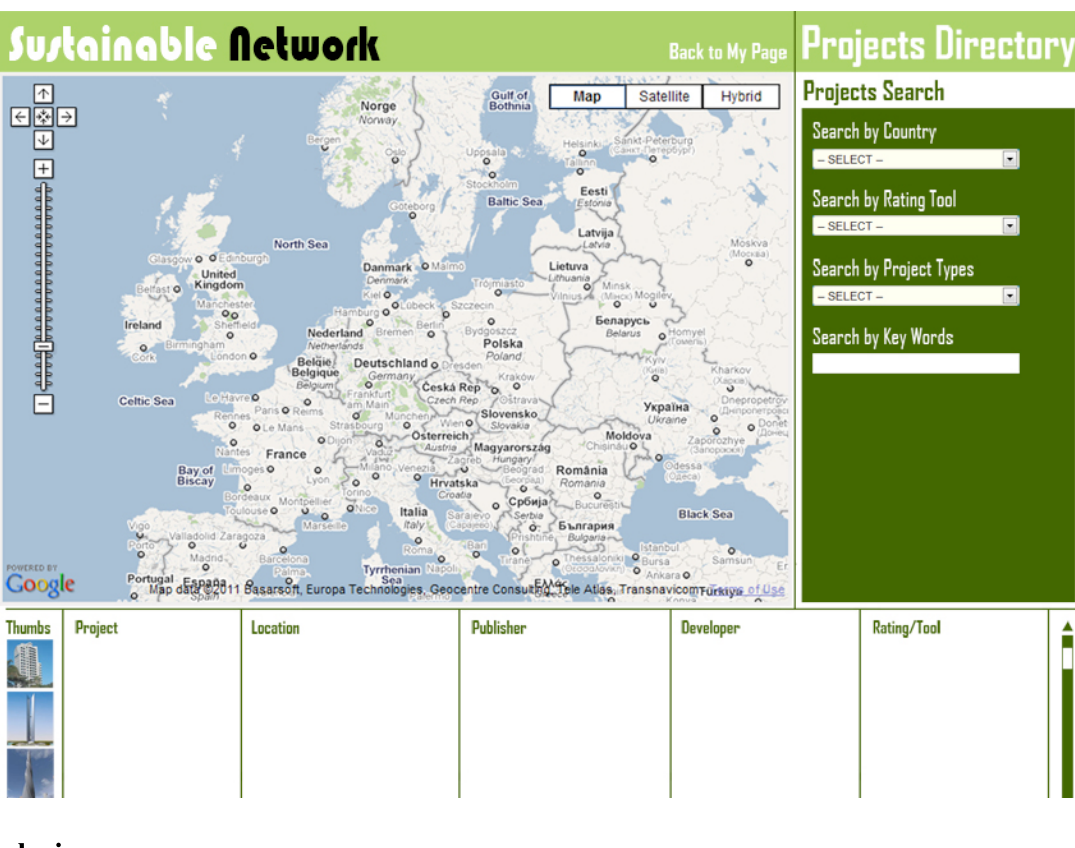
Figure 10. Sustainable Network—Project